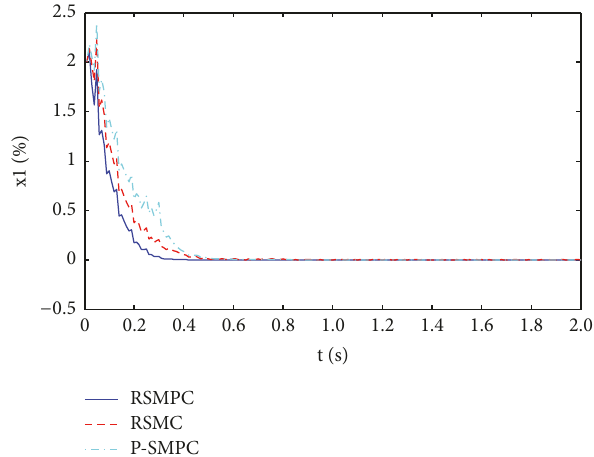
Figure 8: Response curves of system state 𝑥 1 under disturbance condition 3.